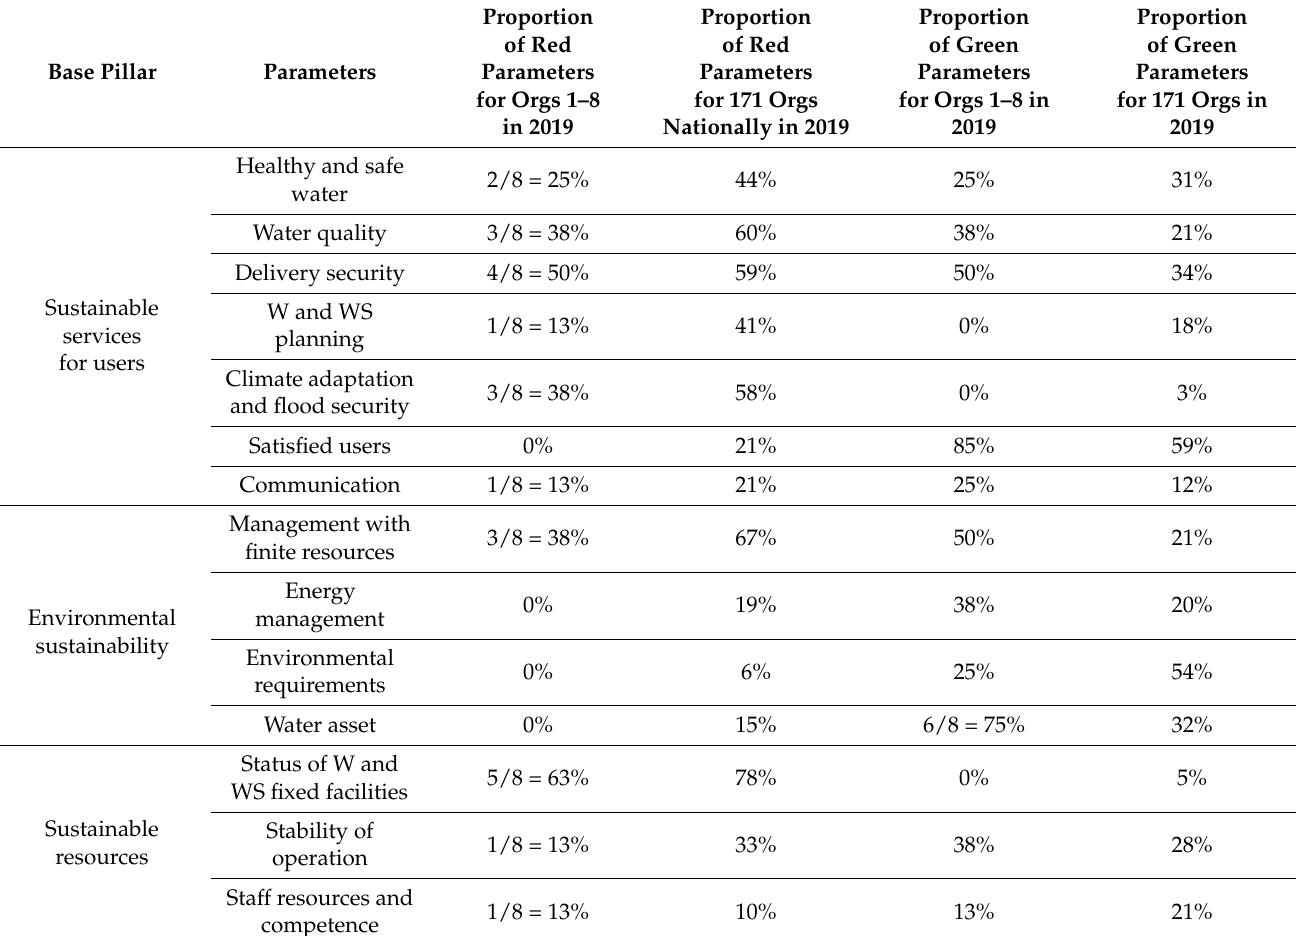
Table 1. Proportion of red and green parameters for Orgs 1–8 and 171 organizations that participated nationally, in percent. Base Pillar Parameters